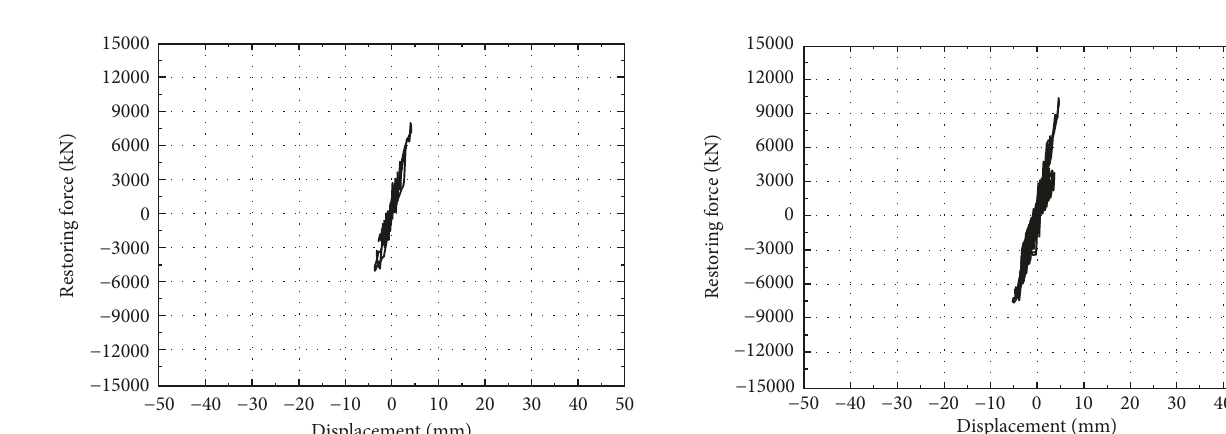
Figure 23: Hysteresis curve of intensity 7 frequently of Imperial Valley (transverse input).